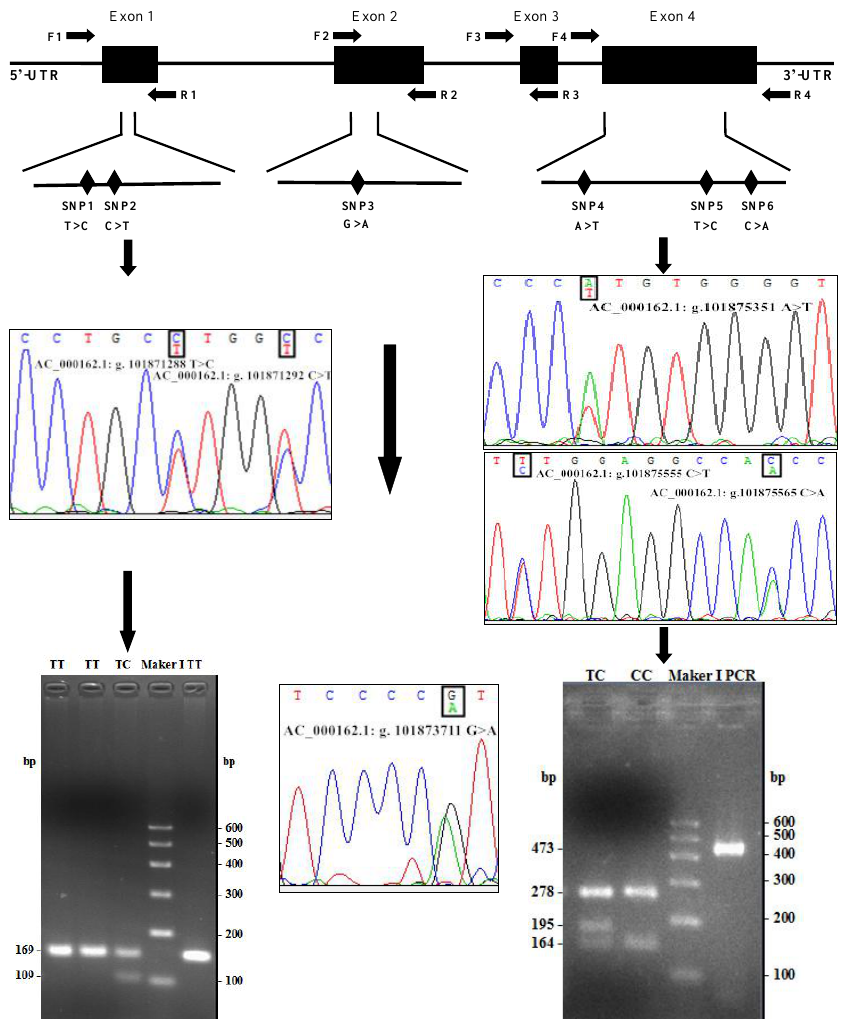
Figure 1. Sequencing of six SNPs and electrophoretograms of SNP1 and SNP5. Note: electrophoresis images show PCR-RFLP on SNP1 and SNP5. At SNP1, TT had 169bp and TC had 169bp and 109bp. At SNP5, CC had 278 + 164bp and TC had 278 + 195 + 164bp; total length of the fourth exon: 473bp.